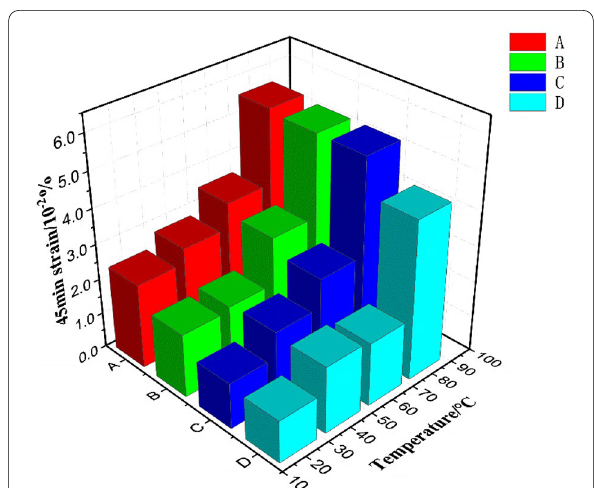
Fig. 6 45-min strain of white oak specimens at different temperatures and distributions of vessel